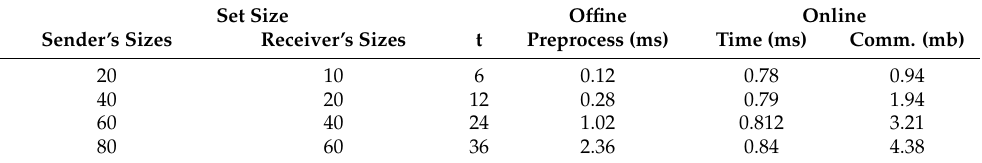
Figure 4. Communication overhead for different schemes with different numbers of symptoms. Table 5. The communication and time cost of STLPSI protocol with different set sizes.